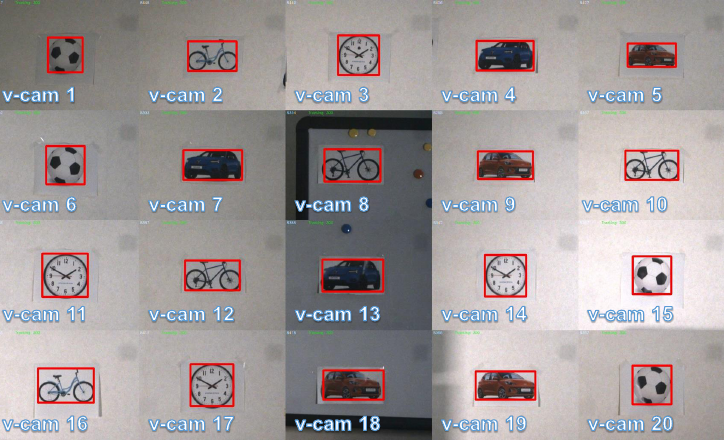
Figure 7. HD images of twenty objects tracked simultaneously.